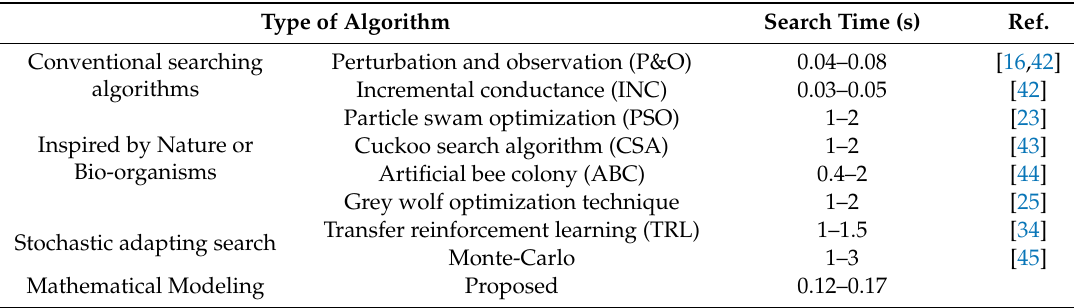
Table 1. Comparison between search time for di ff erent MPPT